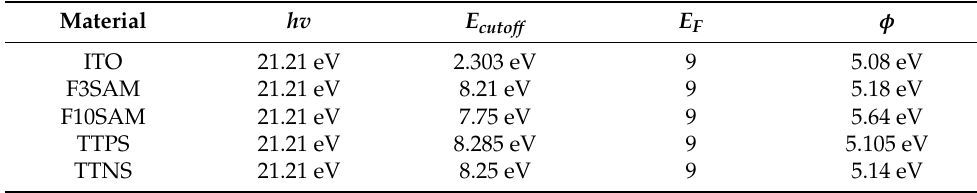
Figure 5. Results of work function UPS measurements. Table 2. Results of UPS measurements.